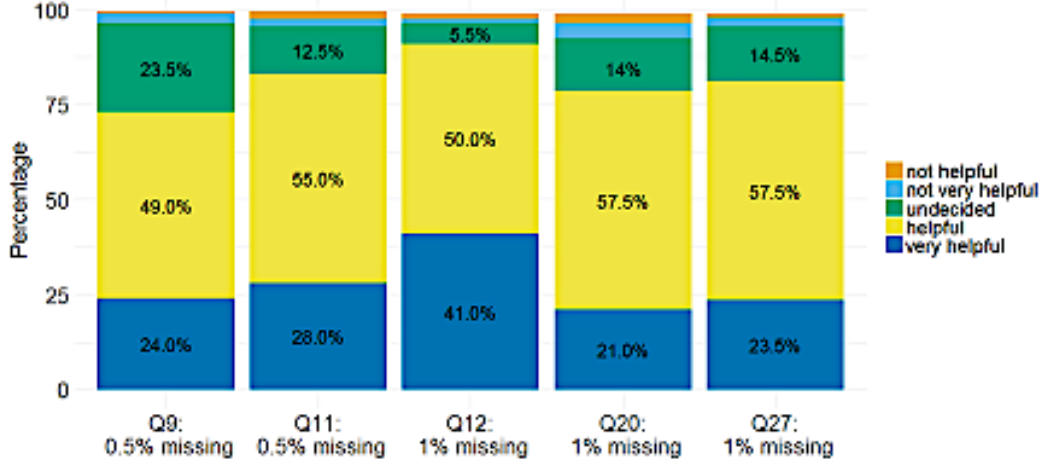
Figure 2. Distribution of the answers provided to selected questions regarding the helpfulness of mobile app–based therapy support in different situations.